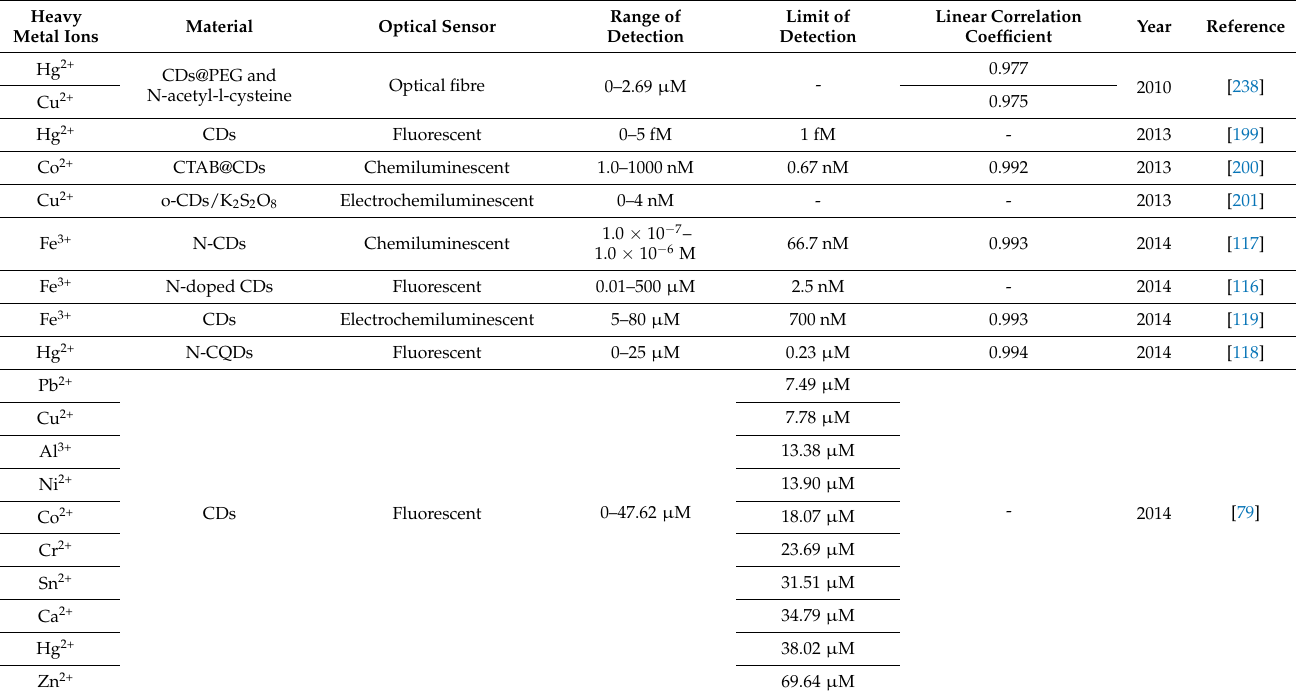
Table 10. Summary of the developed optical sensors for heavy metal ions